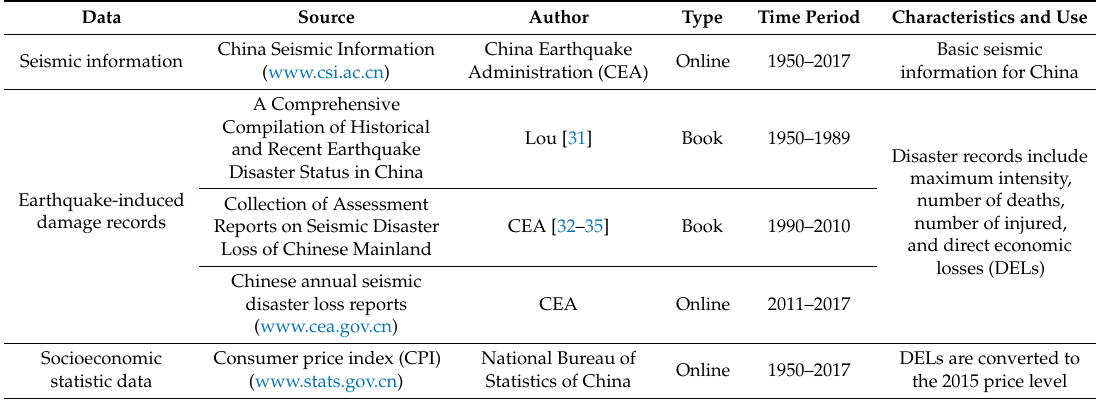
Table 1. Main data sources used in this